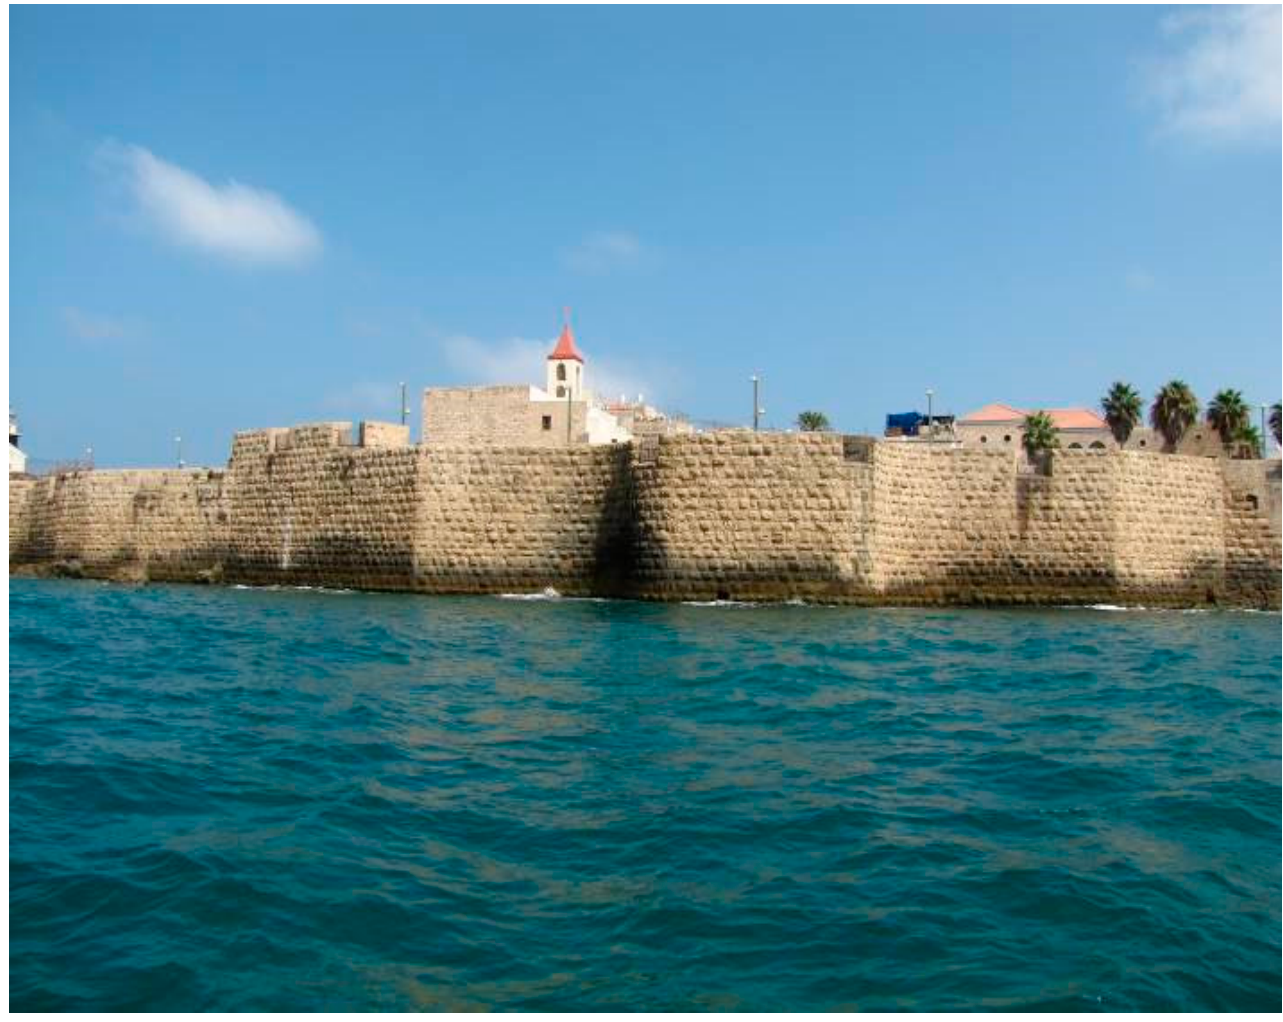
Figure 2. Historic sea wall in Acre. Captured by author on 27 November 2018.